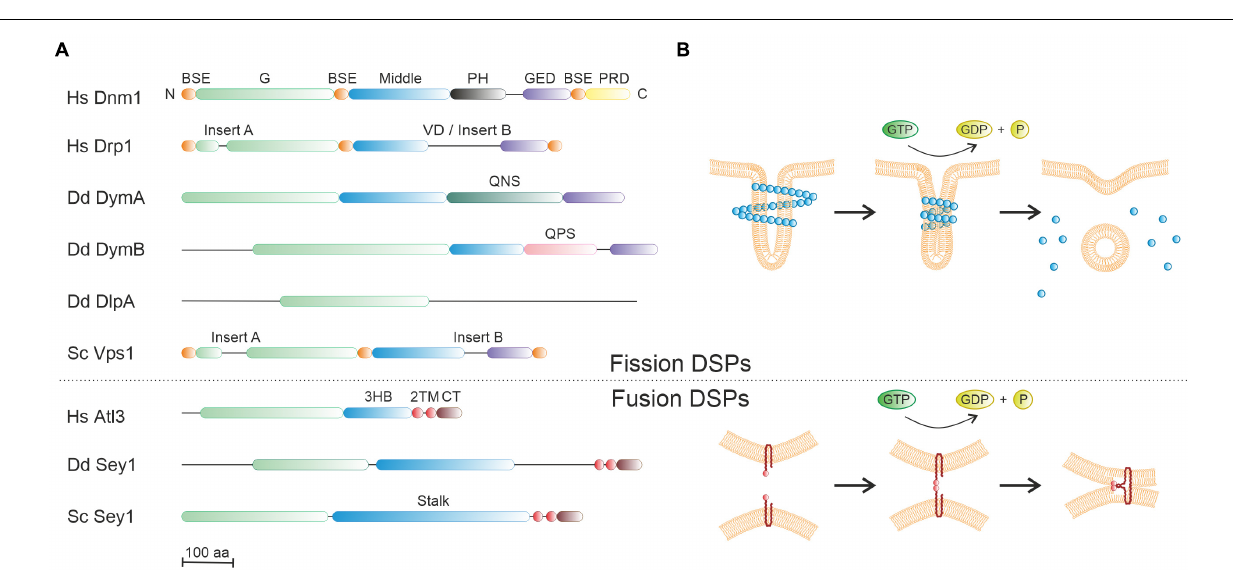
FIGURE 3 | Molecular architecture and mode of action of dynamin superfamily proteins. (A) Domain organization of representative members of dynamin superfamily proteins (DSPs) from human, D. discoideum or S. cerevisiae . The large GTPase domain (green) is conserved, and the “stalk/middle” domains (blue) along with the BSE (orange) fold into a four- or three-helix bundle. BSE, bundle signaling element; G, GTPase domain; GED, GTPase effector domain; PH, pleckstrin homology domain; PRD, proline rich domain; 3HB, three-helix bundle; VD, variable domain; TM, transmembrane domain; CT, cytosolic domain; QNS, glutamine-asparagine-serine-rich domain; QPS, glutamine-proline-serine-rich domain. (B) The putative mode of action of fission DSPs (upper panel) and fusion DSPs (lower panel). The basic unit of fission and fusion DSPs is a dimer or a monomer, respectively. Fission DSPs (e.g., dynamin) are dimeric cytosolic